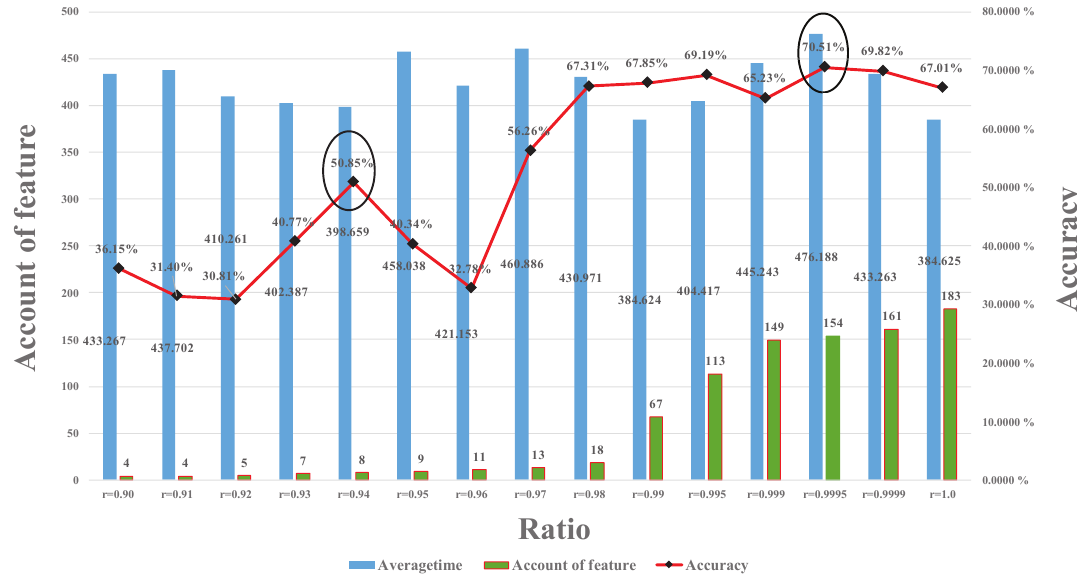
Figure 9. The different ratio of I-ELM+A-PCA